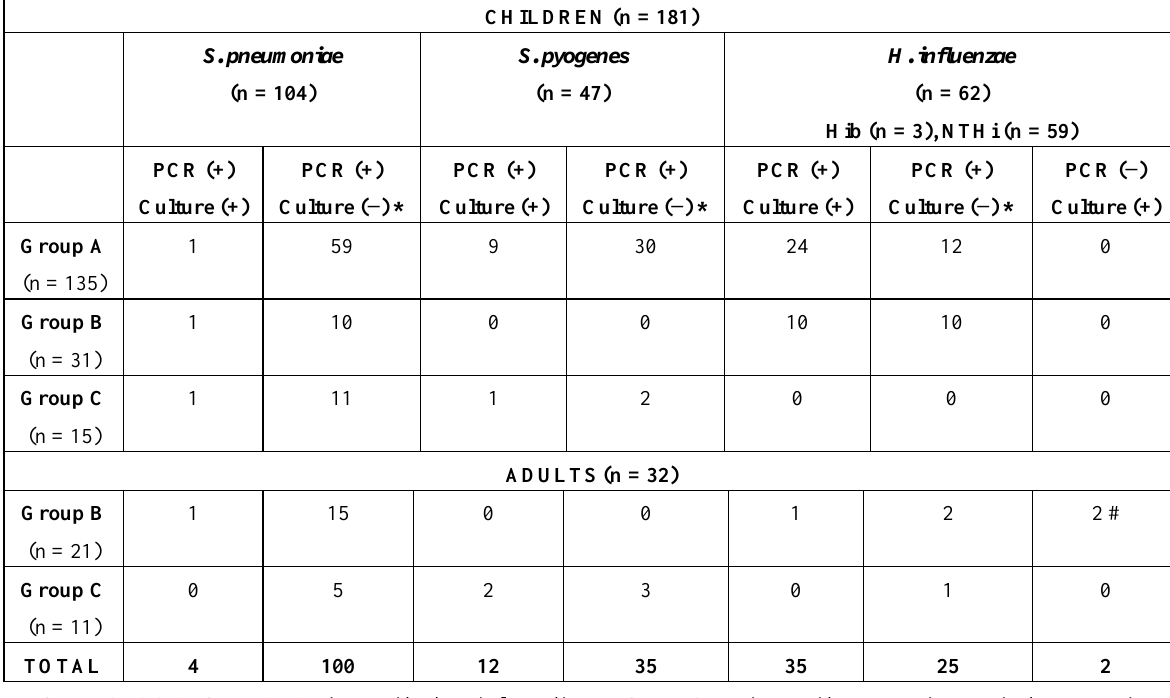
Table 2. Detection of bacterial DNA in clinical samples according to the organism involved, patient category and age